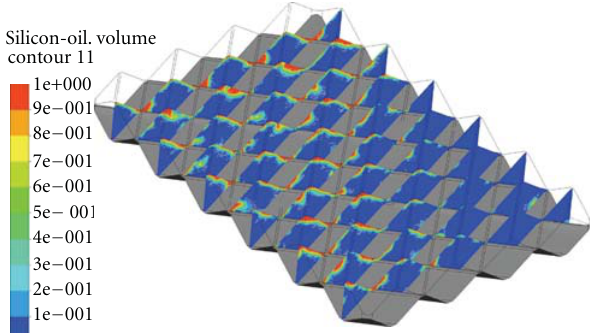
Figure 20: Contour of silicon-oil volume fraction at di ff erent heights of corrugated sheet of packing simulated in the flow direction for inlet position 2. Vol. Flow rate = 811